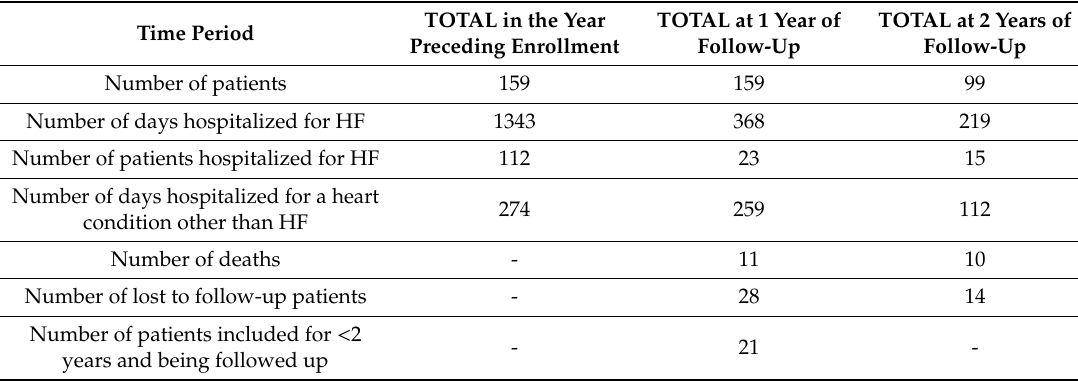
Table 2. Overall results in the whole population before and after inclusion in the USICAR ( Unit é de Suivi des Patients Insu ffi sants Cardiaques )